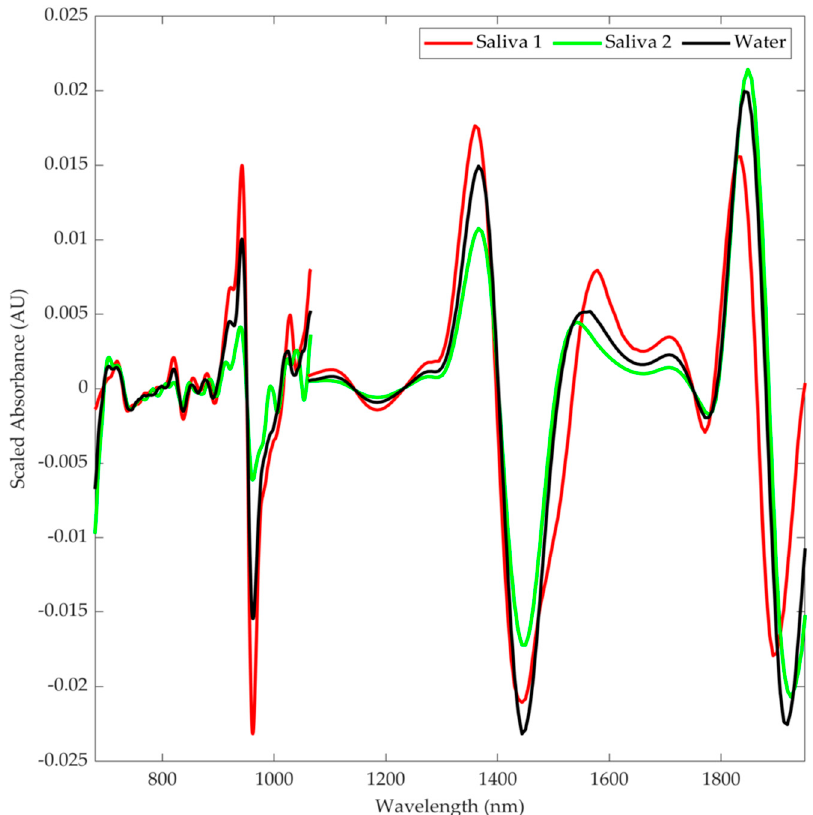
Figure 5. The 2nd derivative NIR spectra of two saliva samples of oral cancer patients and pure water as a comparison. Saliva 1 was collected from a 73-year-old male patient and saliva 2 was collected from a 76-year-old male patient.